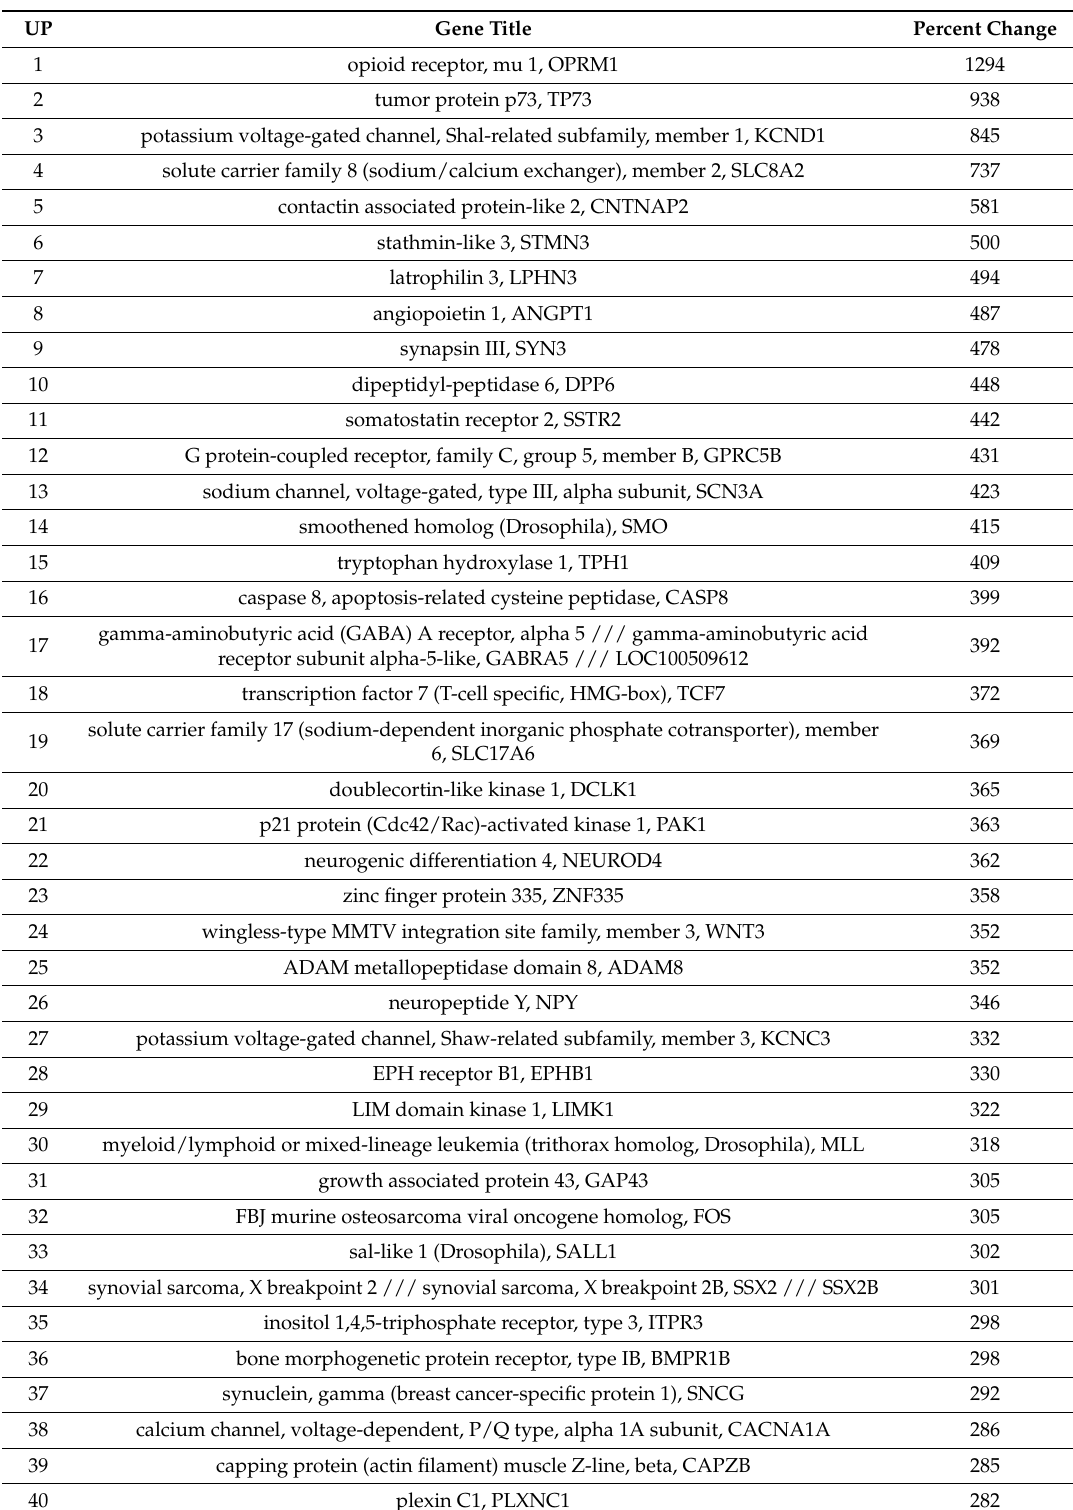
Table 12. GHK and Genes Associated with